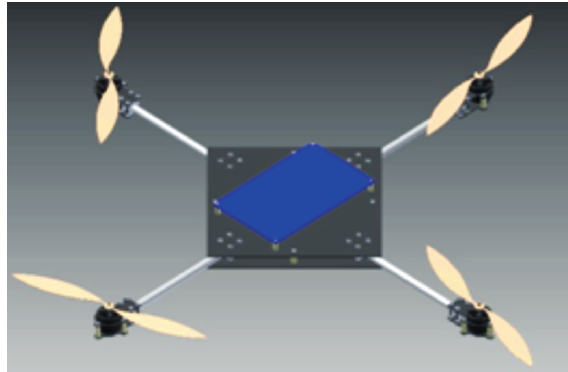
Fig. 1. The quadrocopter’s CAD in inventor An aluminum tube with an outside diameter of 10 mm, 8 mm inner diameter and 180 mm length has been used to create a single arm. The tube is made of aluminum alloy PA6 and weighs 14 g. A strength analysis of this element has been performed. The tube was at- tached to the platform using specially designed mount- ing brackets shown in figure 2.